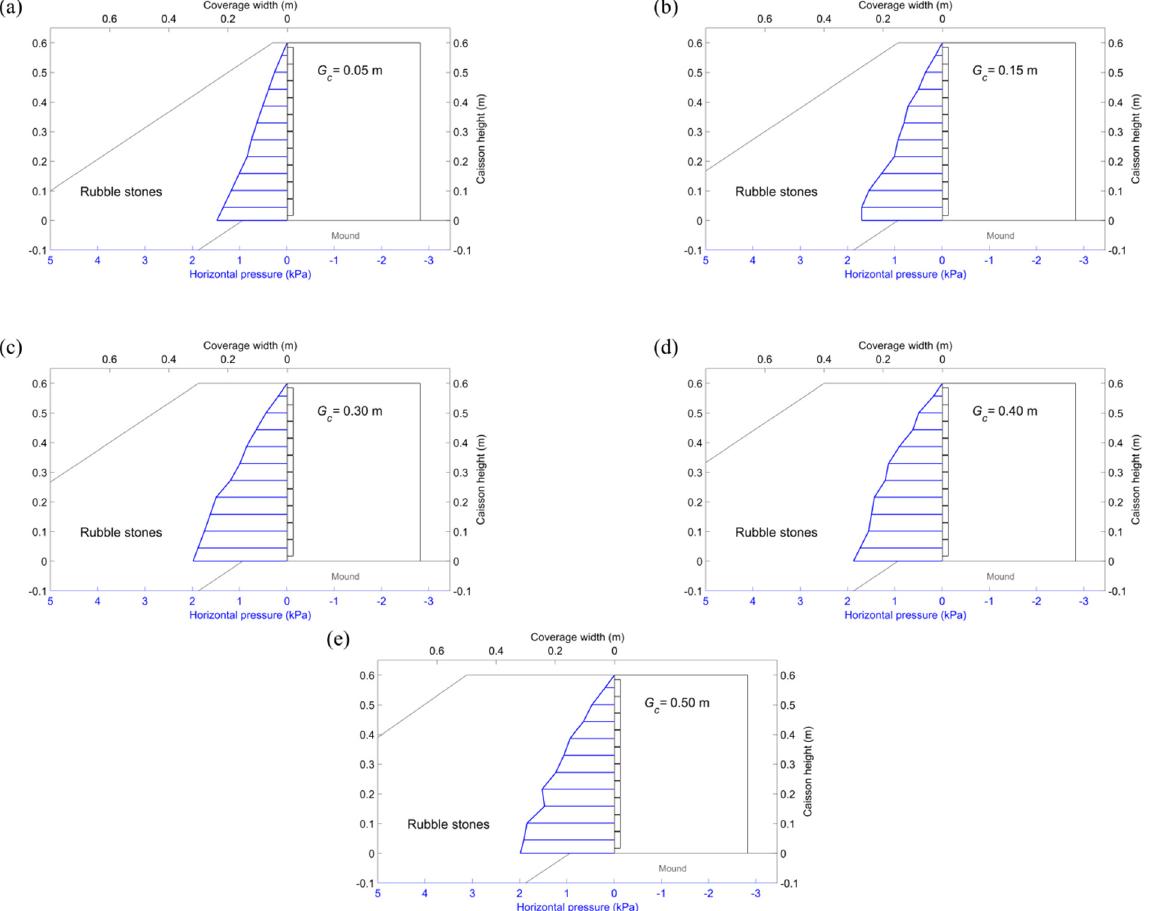
Figure 7. Horizontal pressures exerted by rubble stones for the different shoulder widths. ( a ) G c = 0.05 m, ( b ) G c = 0.15 m, ( c ) G c = 0.30 m, ( d ) G c = 0.40 m, and ( e ) G c = 0.50 m .